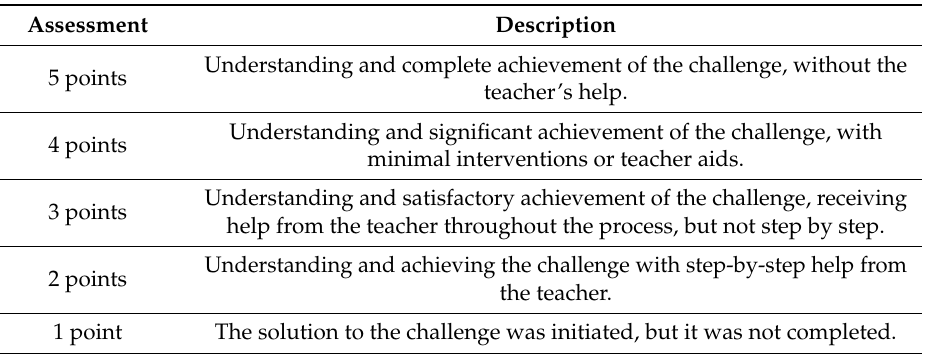
Table 2. Rubric for first